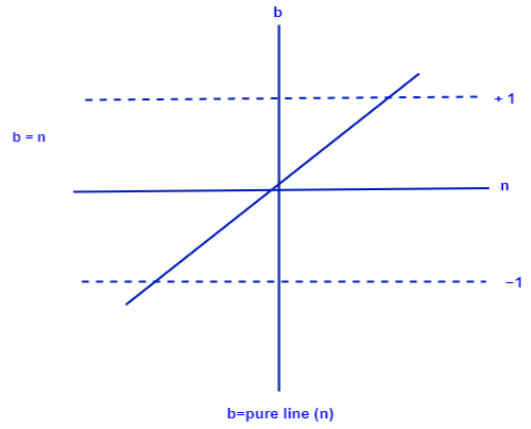
Figure 9. Linear transfer function.